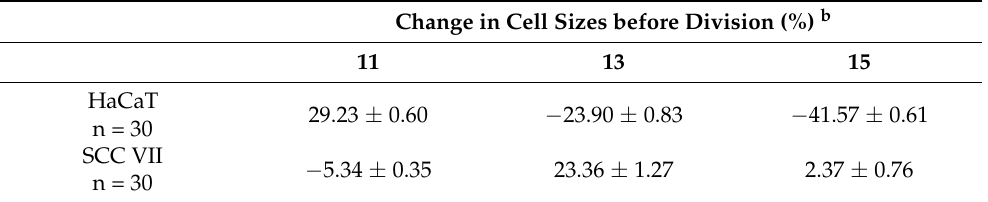
Table 3. The effect of compounds 11 , 13 and 15 on the size of mother cells a .